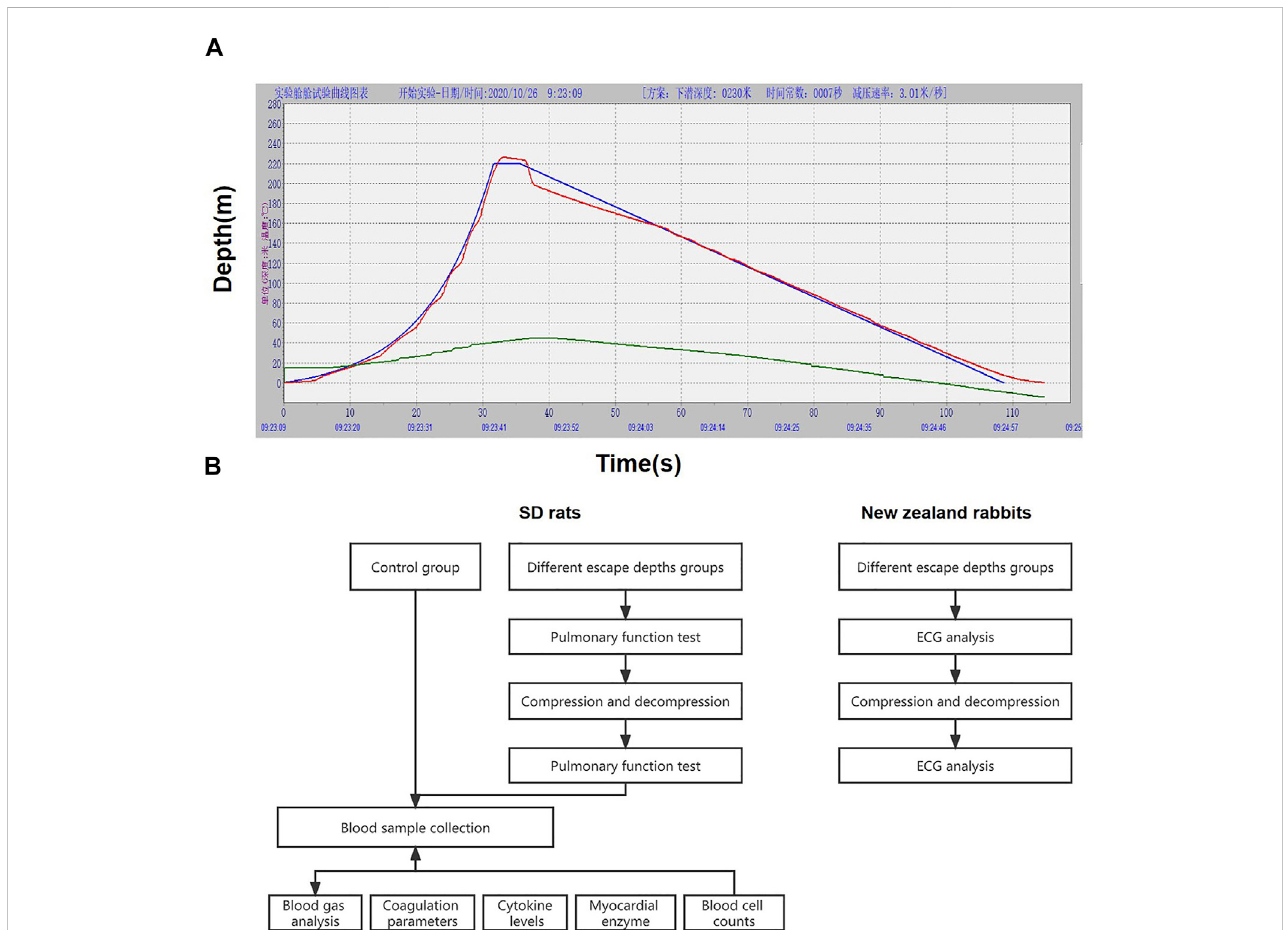
FIGURE 1 Pressure and decompression curves (A) and experimental fl ow chart (B) . Figure A is the 220 m escape curve, the green curve is the ideal pressure and decompression curve simulated by the computer, the red curve is the actual pressure and decompression curve, and the blue curve represents the temperature in the